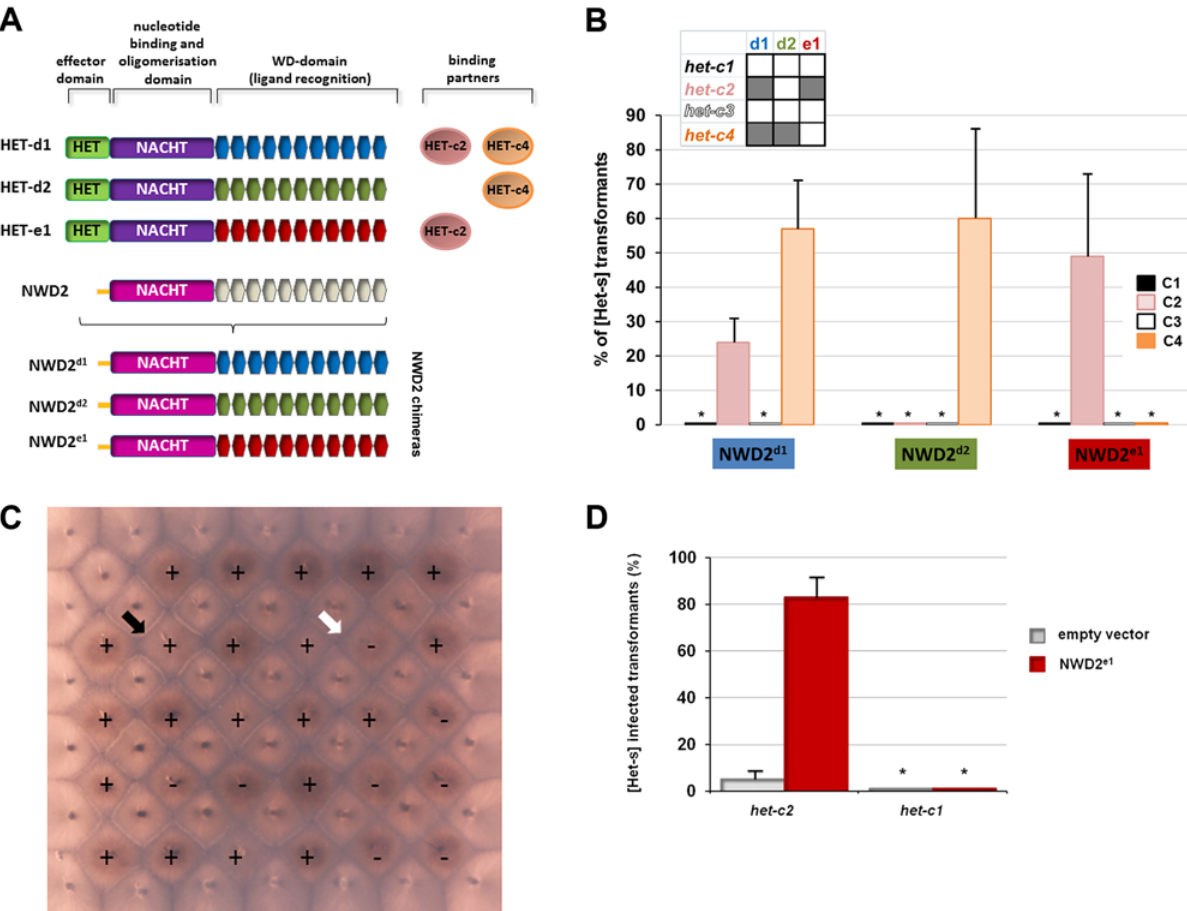
Fig 2. NWD2 chimeric alleles induce [Het-s] prion formation specifically in the presence of their cognate ligand. A. The domain organization of HET- d1, HET-d2, and HET-e1 are presented together with the HET-c variants they recognize and compared to the domain organization of NWD2. HET-d/e and NWD2 share a NACHT and a WD-repeat domain but differ in the N-terminal region, which corresponds to a HET, cell death — inducing domain in HET-d and HET-e (green box) and a region homologous to the PFD in NWD2 (yellow segment). In the bottom panel, the chimeric NWD2 variants that were constructed and in which the WD-repeat domain has been replaced by the corresponding domain from HET-d1, HET-d2, and HET-e1 are presented. B. Fraction of transformants converted to the [Het-s]-prion phenotype after transformation with different chimeric alleles of NWD2 (as noted). Results are given for four different het-c backgrounds ( het-c1 , het-c2 , het-c3 , and het-c4 ). In the inset, the interaction patterns between d1, d2 and e1 WD-domains and the different het-c alleles are recalled (after [47]). A grey box indicates that the het-c allele is recognized by the WD-domain; a white box indicates lack of interaction. Experiments have been carried out at least in triplicate and error bars are standard deviations; the asterisks denote that prion formation rate was zero. C. Raw data from a representative experiment is presented to illustrate how results were collected. Twenty-nine Δ Hsp104 [Het-s * ] het-c4 strains transformed with the nwd2 d1 chimeric allele (marked by + or-) were tested in barrage assays in confrontation to het-S testers (each transformant is surrounded by four het-S tester strains). Transformants presenting a barrage reaction to the het-S testers are score positive (+); transformants remaining [Het-s * ] after transformation show no barrage reaction and are score negative (-). The black and white arrows point to examples of presence and absence of a barrage reaction, respectively. On this plate, 21 out of 29 tested strains acquired [Het-s] after transformation with the chimeric nwd2 allele. D. NWD2 e1 induces [Het-s] prion formation in a ligand-dependent manner in a wild-type strain for PaHsp104 . Fraction of transformants converted to the [Het-s]-prion phenotype after transformation with nwd2 e1 in het-c1 and het-c2 backgrounds (wild-type for PaHsp104 ). Experiments have been carried out at least in triplicate and error bars are standard deviations; the asterisks denote that prion conversion rate was zero.